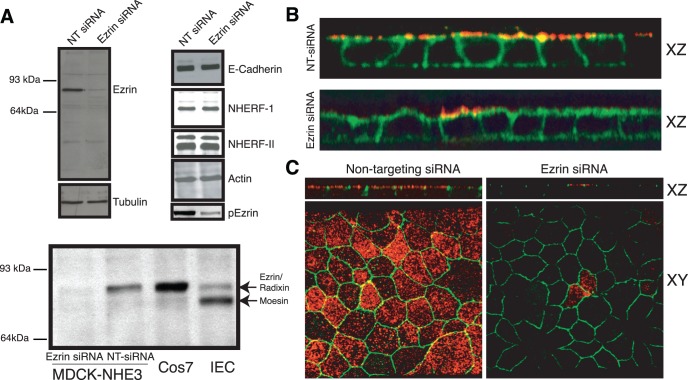
Ezrin knockdown in vitro does not induce radixin or moesin expression, nor alter epithelial morphology.A) Representative immunoblots (n≥3) for ezrin, tubulin, actin, E-cadherin, NHERF-I, NHERF-II and phosho-ezrin of whole cell lysates (NHE3’38HA3,cells) after treatment with non-targeting siRNA or siRNA targeted against ezrin. Whole cell lysate from Cos7 and IEC cells were included as controls. B) XZ reconstruction of confocal stacks of a monolayer of NHE3’38HA3 cells labeled with ezrin (red) and treated with Alexa488-conjugated phalloidin (green) after treatment with non-targeting siRNA or siRNA targeted against ezrin. C) XZ reconstruction of confocal stacks, and apical XY images, of a monolayer of NHE3’38HA3 cells labeled with ezrin (red) and ZO-1 (green) after treatment with non-targeting siRNA or siRNA targeted against ezrin.